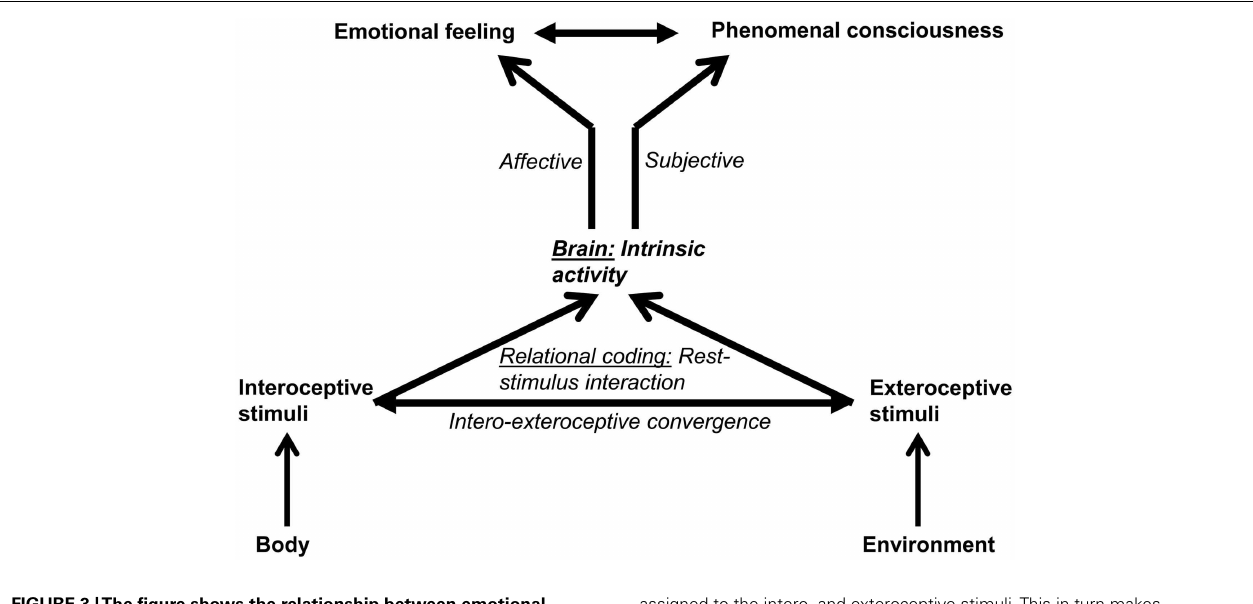
FIGURE 3 |The figure shows the relationship between emotional feeling and phenomenal consciousness. By interacting with the brain’s intrinsic activity via relational coding affect and subjectivity is